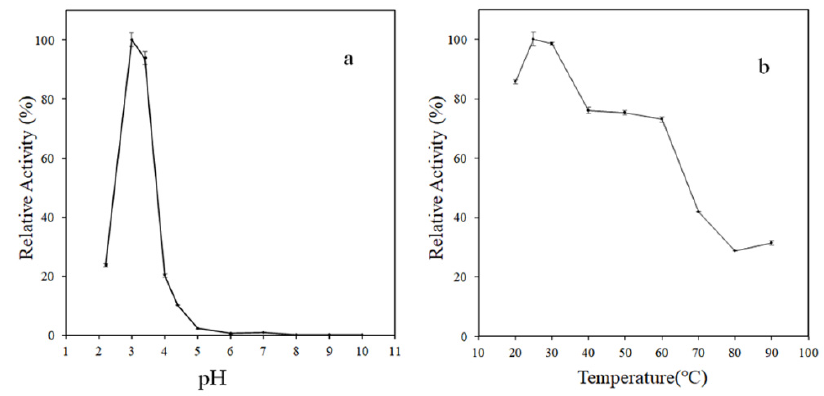
Figure 4. Effect of temperature ( a ) and pH ( b ) on the activity of rMCO towards ABTS.